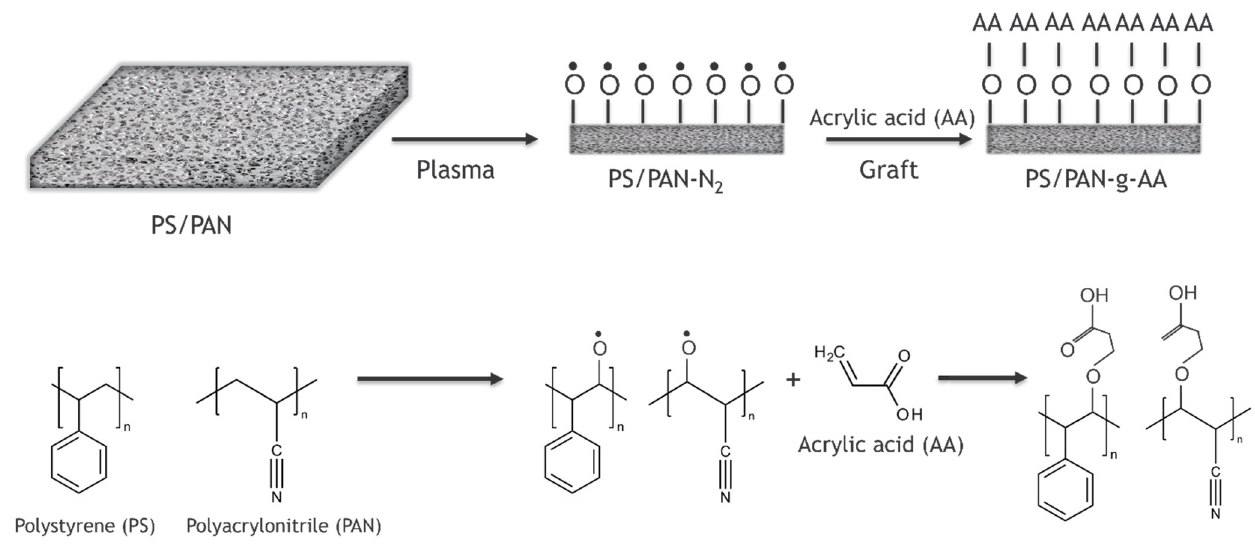
Figure 4. PS/PAN membrane modification by acrylic acid grafting using plasma activation by grafting of radical Oxygen species (O * ).